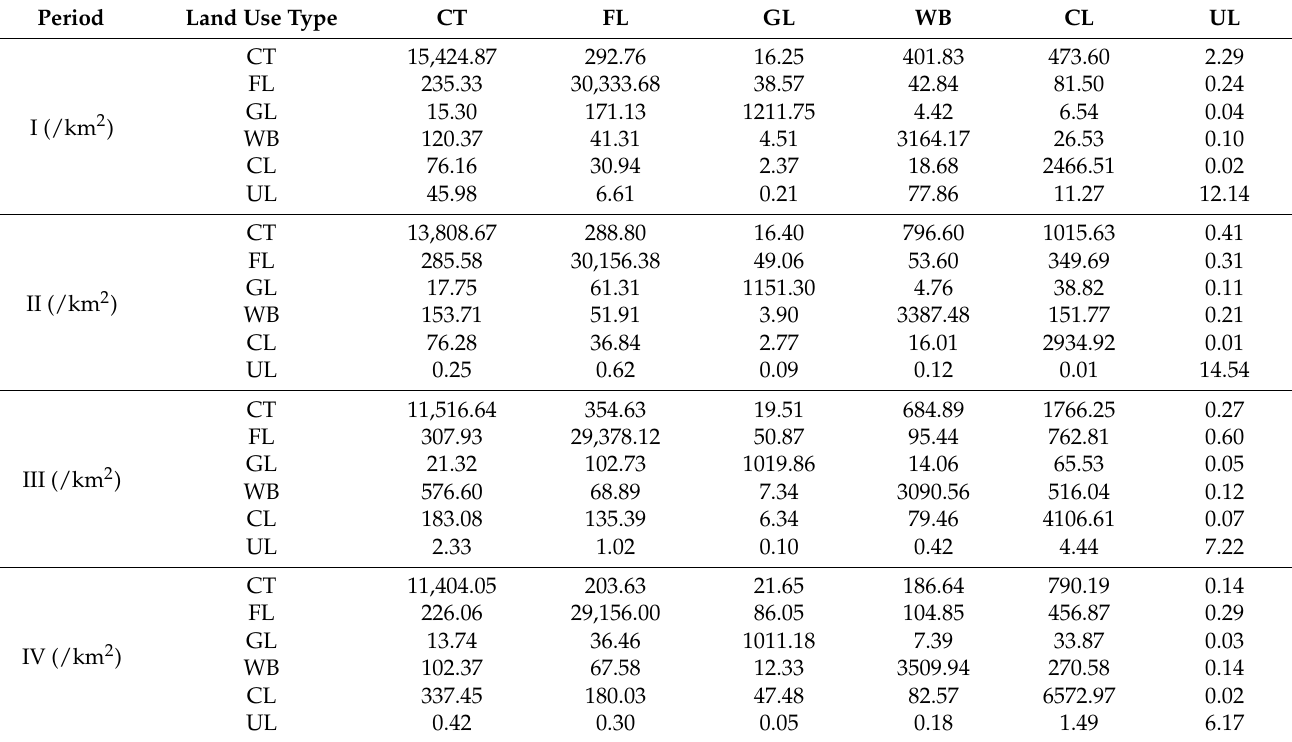
Table 5. Land use transfer matrix by period.